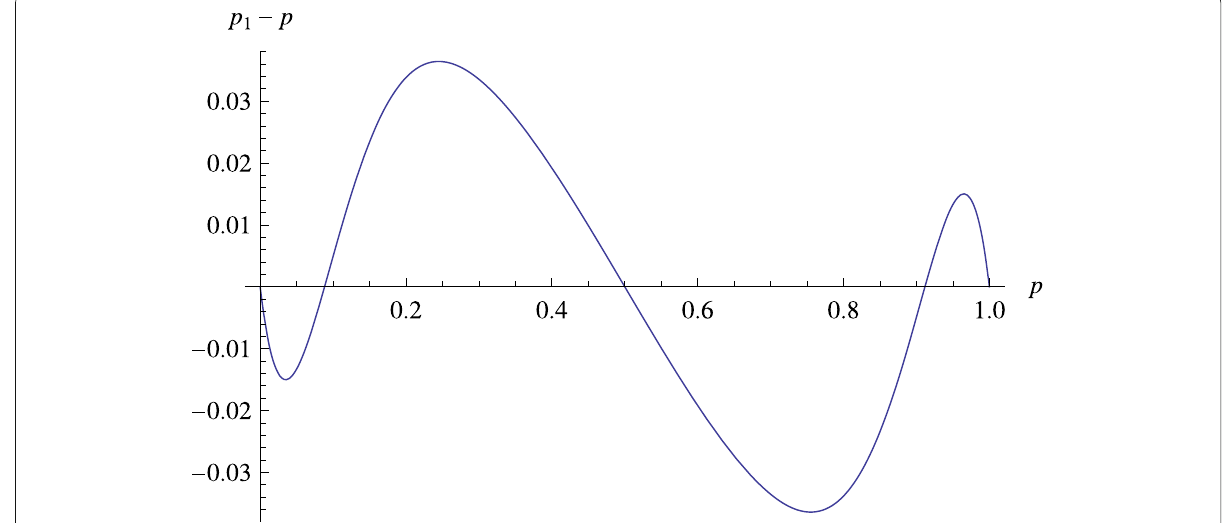
Fig. 3 The error rate after error-correction p 1 varies with the inial error rate p when n =